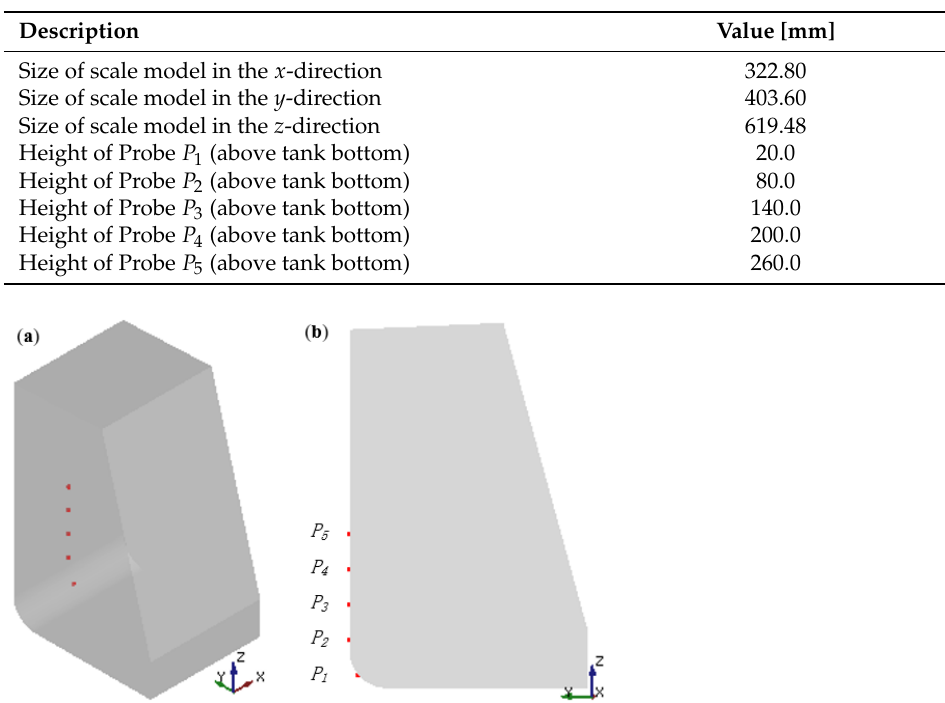
Table 3. Parameters of the scale model of “R2.03AP” and the particular points.